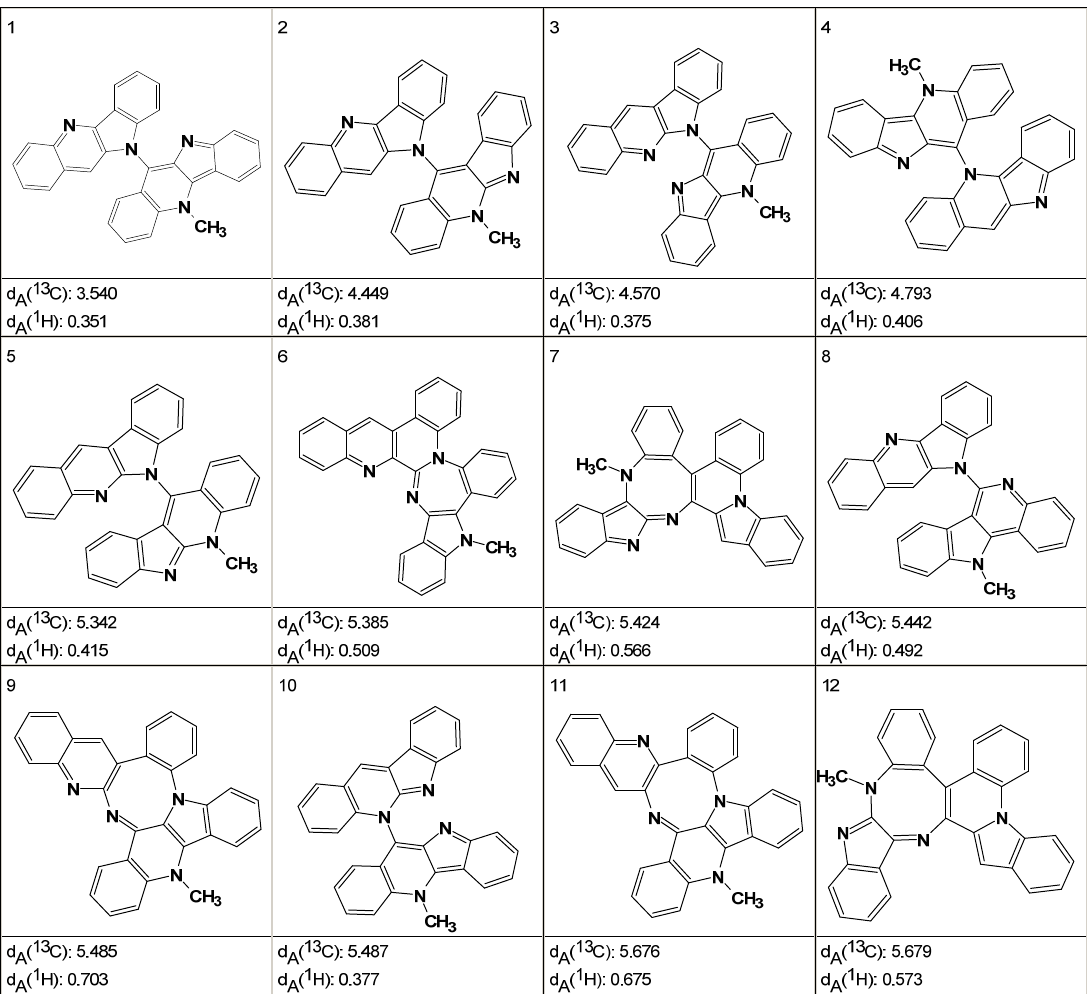
Figure 10. Twelve top ranked structures.